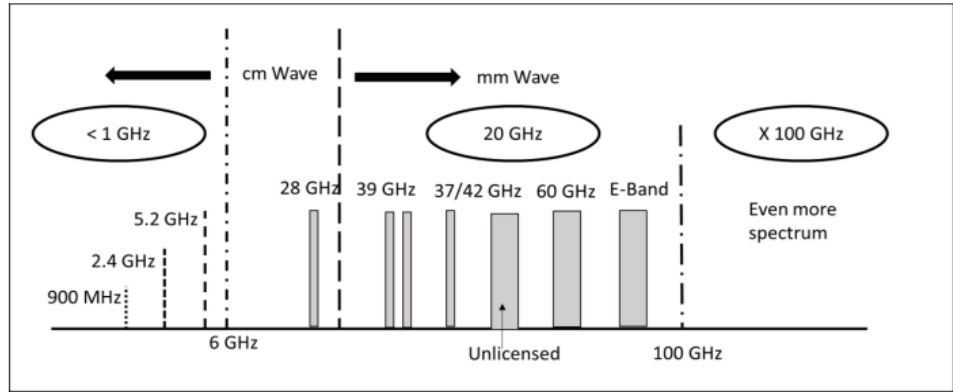
Figure 1. Frequency spectrum for 5G communication.